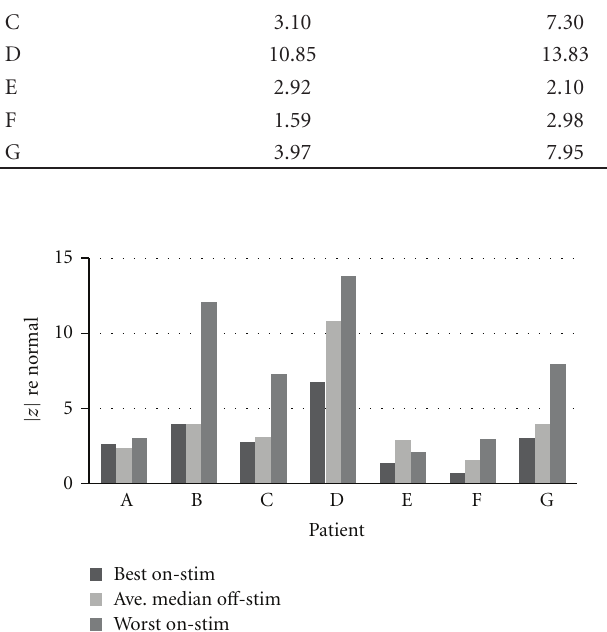
Figure 8: E ff ect of DBS on speech: best and worst settings.